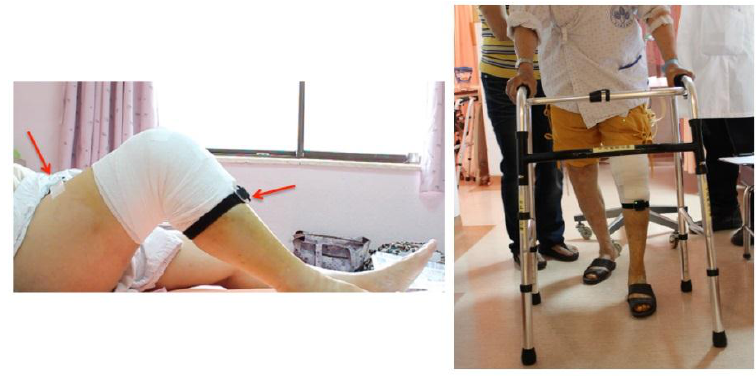
Figure 5. Two sensors were mounted on the anterior side of the thigh and shank.